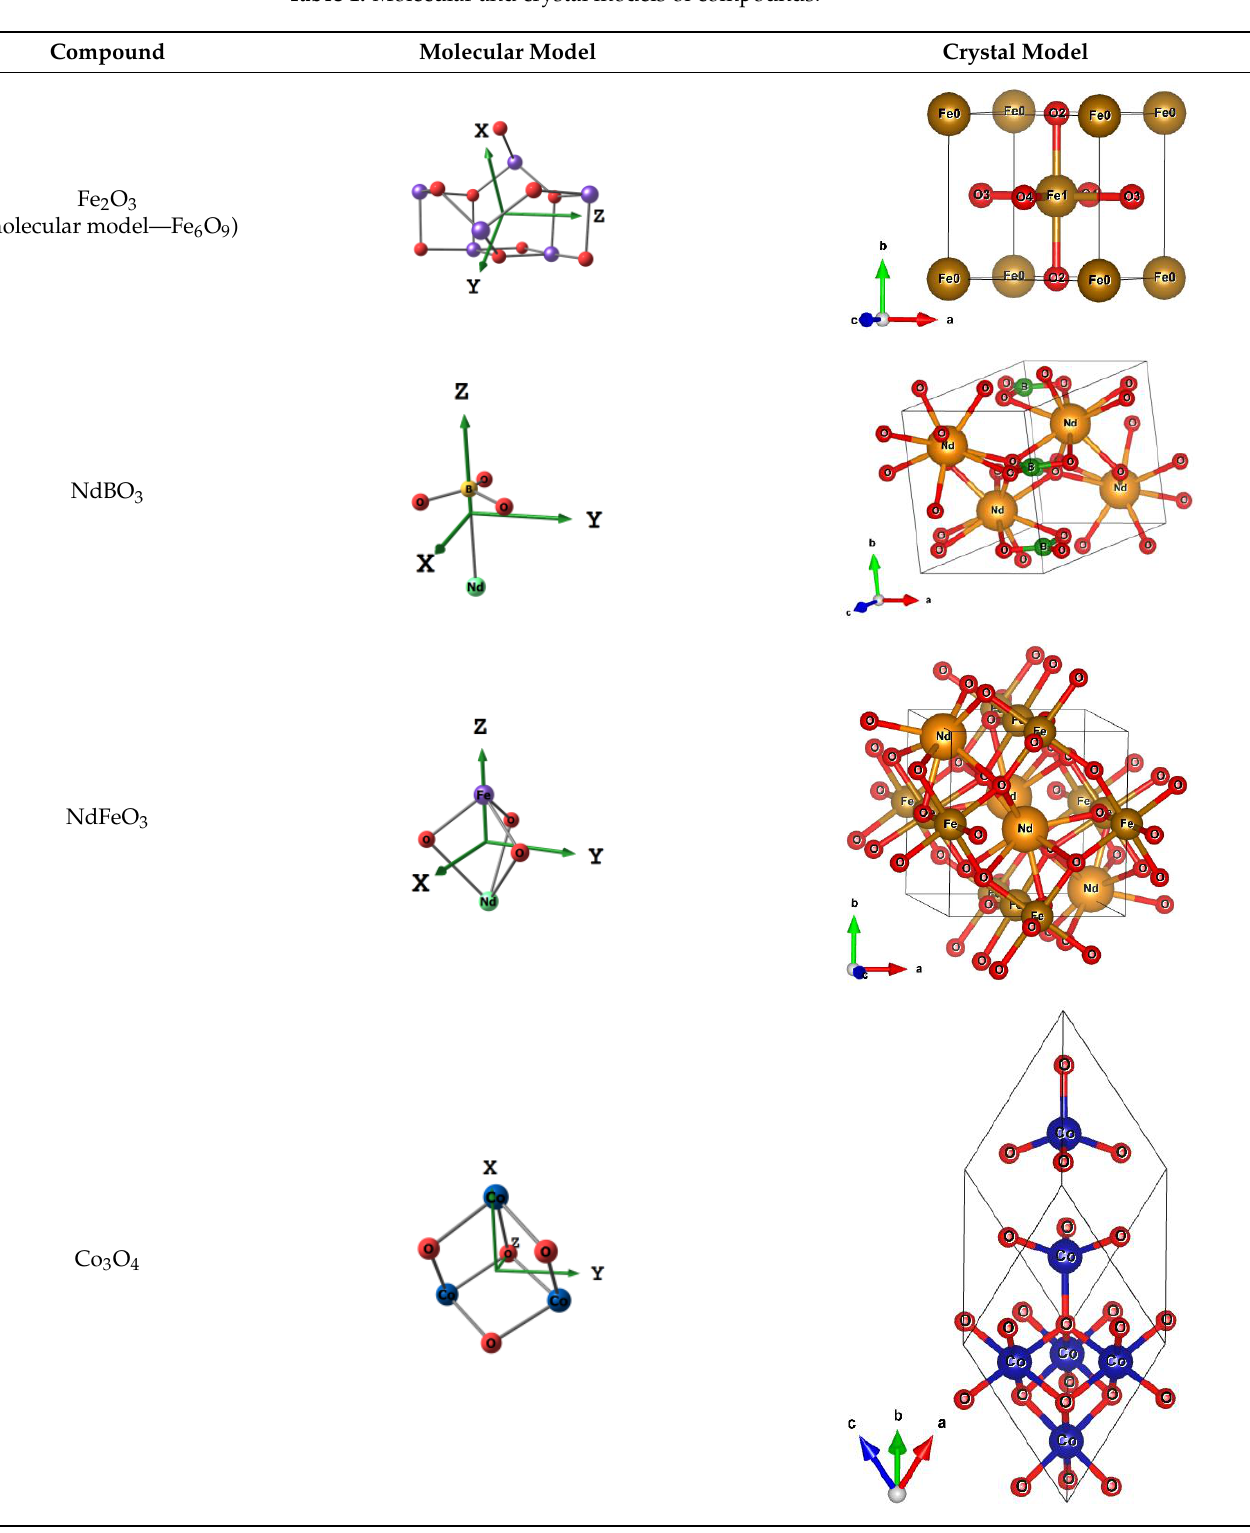
Table 1. Molecular and crystal models of compounds.